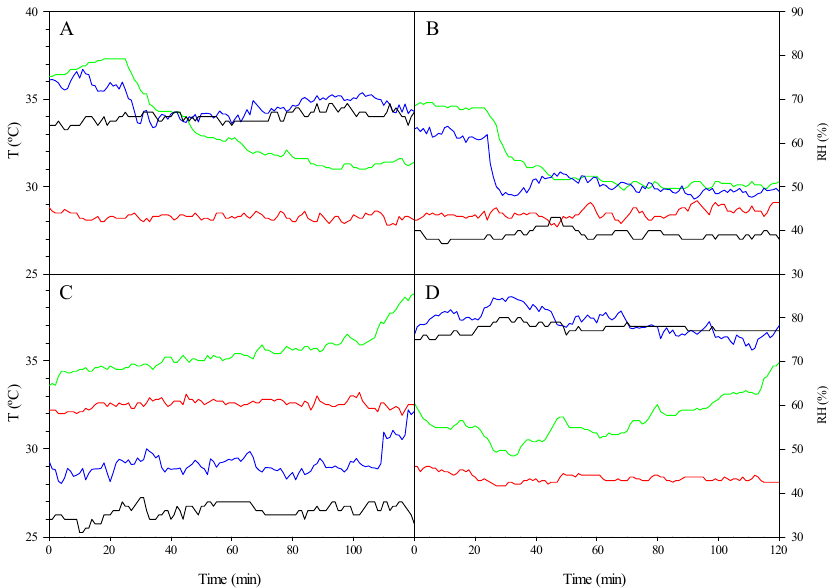
Figure 10. The temperature (indoor, green, and exterior, red) and relative humidity dynamic (indoor, blue, and exterior, black) for the roof ventilation tests between 13:00 and 15:00. Opening ( Δ V > 0; test 2, A and test 9, B); Closing ( Δ V < 0; test 3, C and test 10, D).